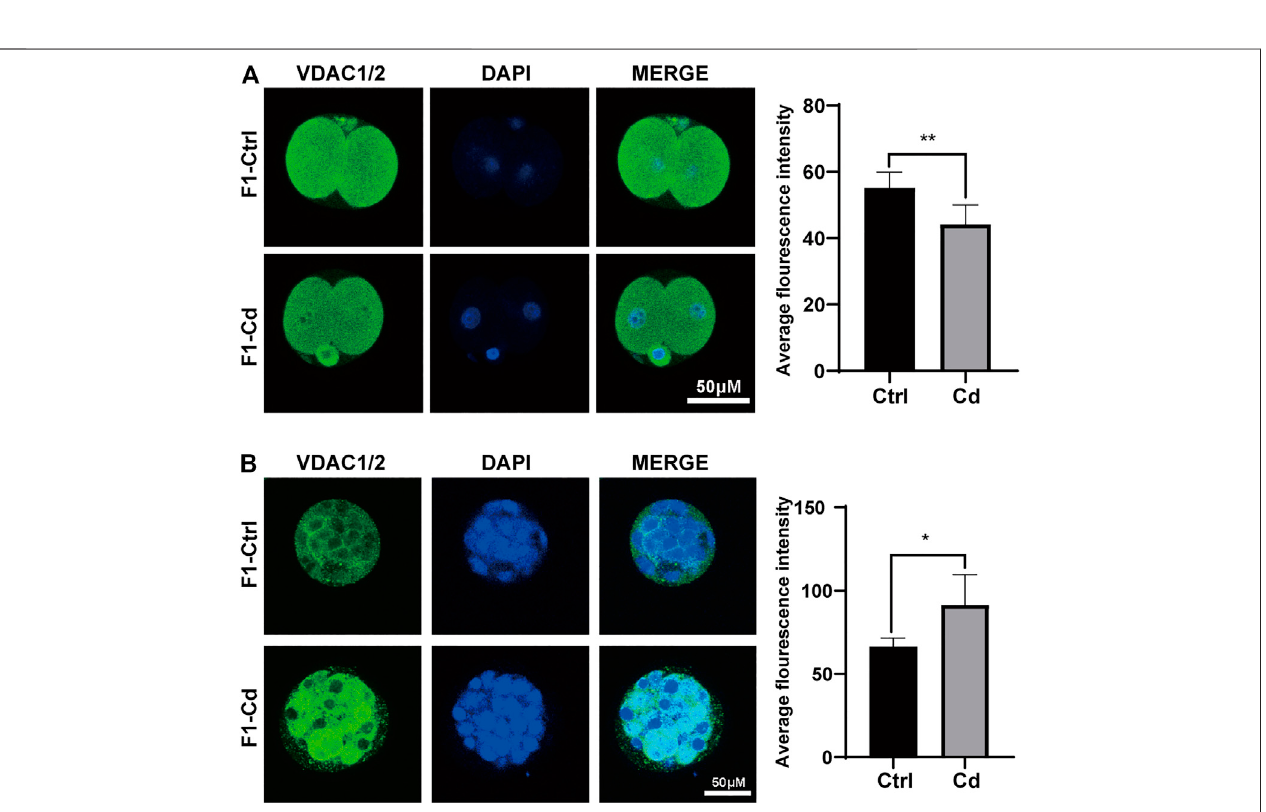
FIGURE5| EffectsofCdexposureonprogenyembryo. (A) Theimmuno fl uorescenceandquanti fi cationanalysisofVDAC1/2in2-cellembryos(scalebar (cid:1) 50 μ m, n (cid:1) 5). (B) The immuno fl uorescence and quanti fi cation analysis of VDAC1/2 in morulas (scale bar (cid:1) 50 μ m, n (cid:1) 5). All results are expressed as the mean ± SD. Labeled asterisk represents statistical signi fi cance compared with the respective control group. * p < 0.05, ** p < 0.01.